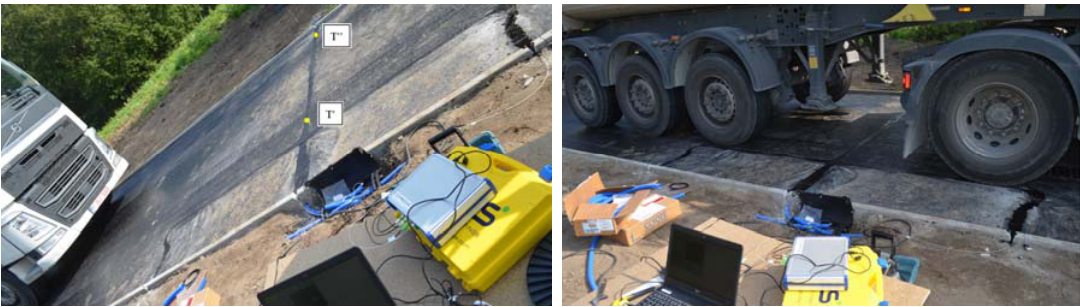
Figure 8. Monitoring of FBGs during the second day during the construction of the second base layer of the CyPaTs bicycle path.